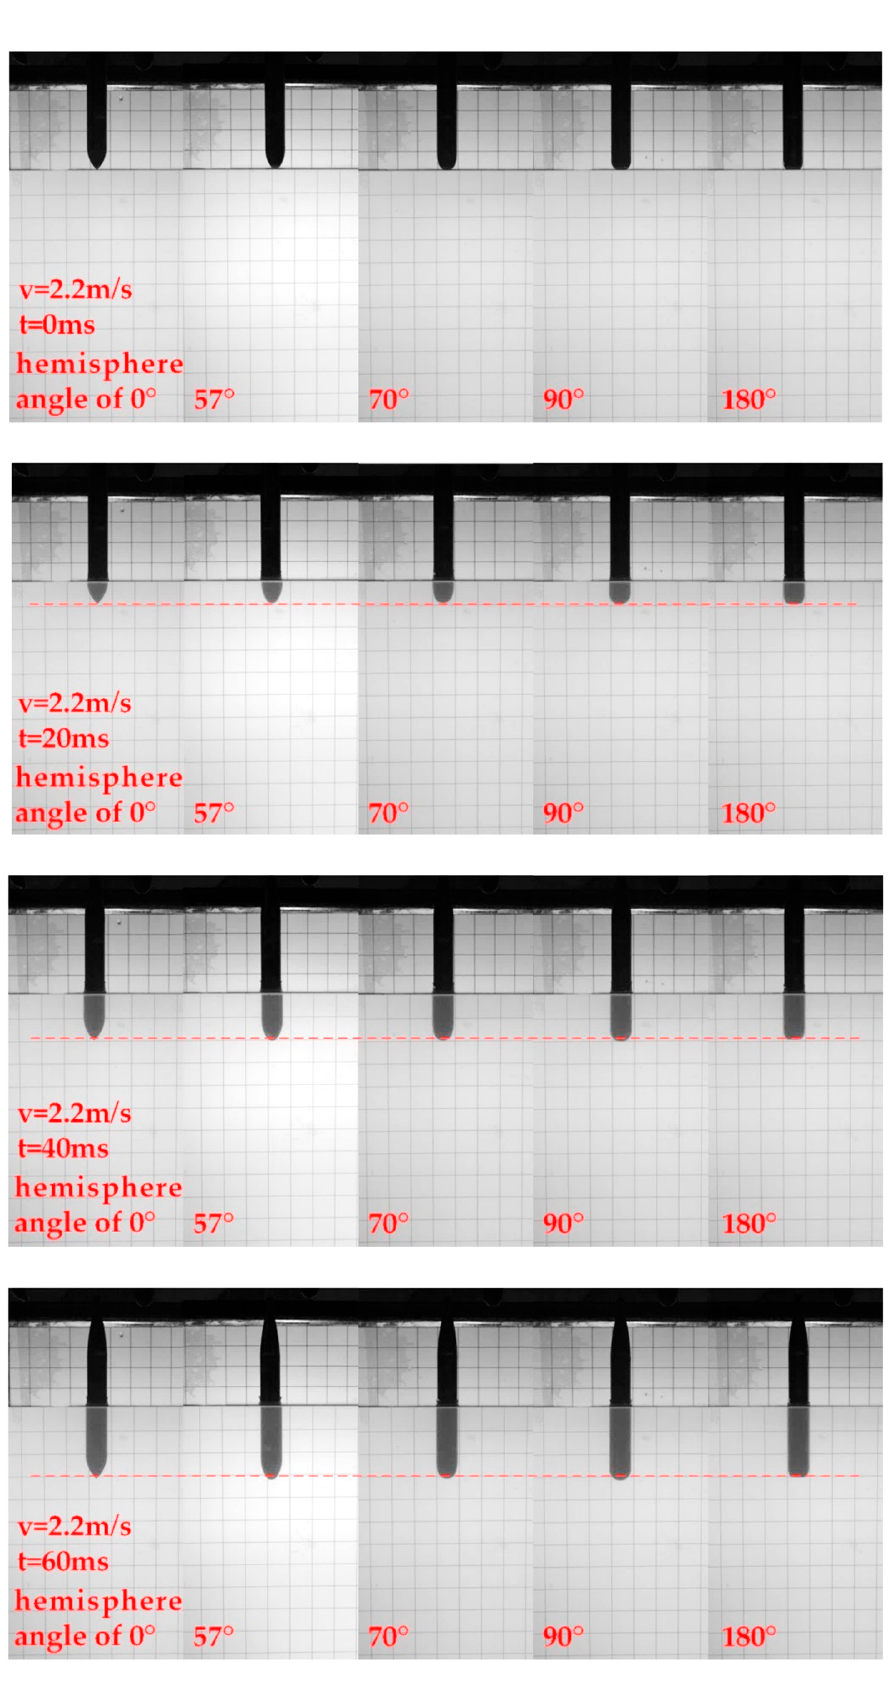
Figure 10. The experimental diagram of the hydrophilic model entering the water at a speed of 2.2 m/s.